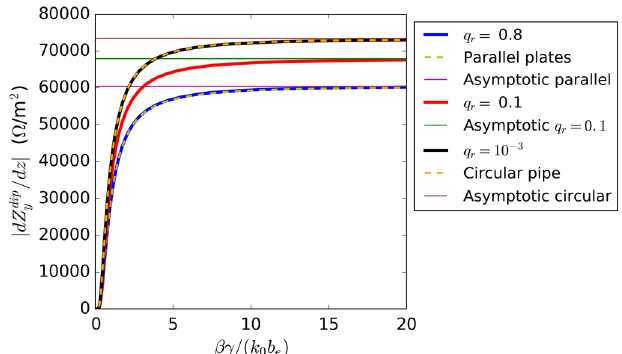
Fig. 5. The vertical and horizontal asymptotic values, equal ffiffiffi ffiffiffi p p 3 = π and 2 6 = π , can be obtained directly respectively to 2 from the Laslett coefficients.